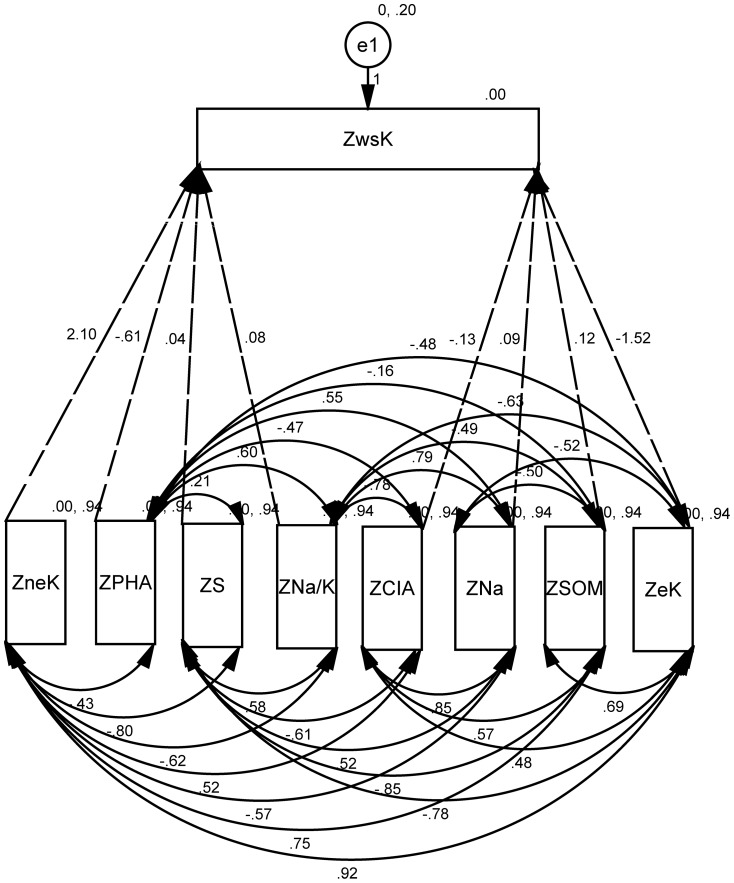
Path model of water-soluble potassium (wsK, solid line for double arrow, dashed-line for single arrow, and single arrow flows into ZwsK).